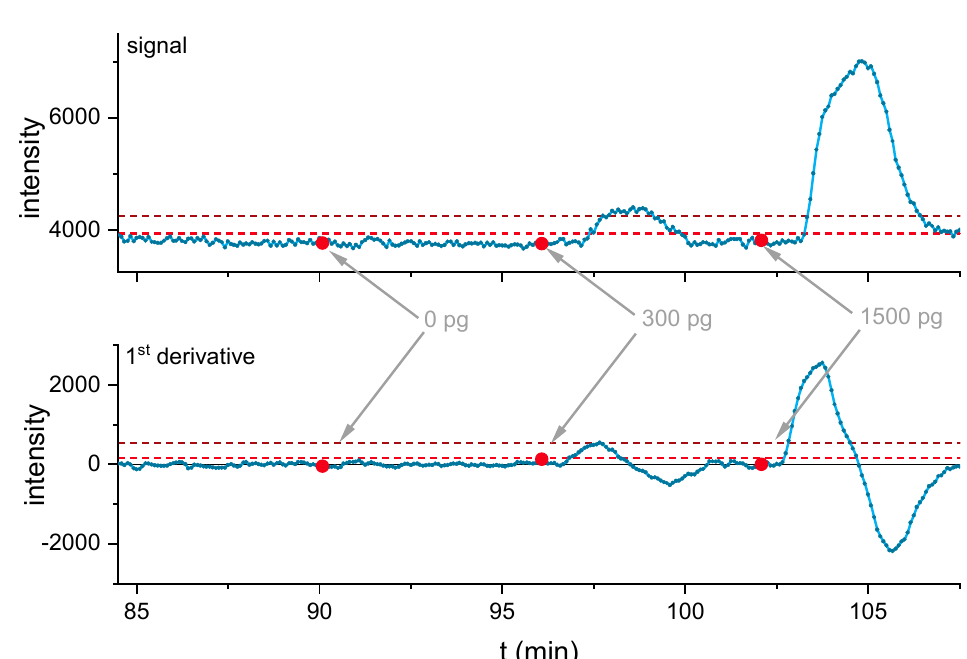
Figure 9. Signals of the first wiped slide, with samples spiked from 0, 300 to 1500 pg cocaine equivalents ( top ) and 1st derivative of the 12-point moving average smoothed signal ( bottom ). The limit of detection (light red dashed line) and the limit of quantification (dark red dashed line) were highlighted and are based on the baseline of the blank samples.